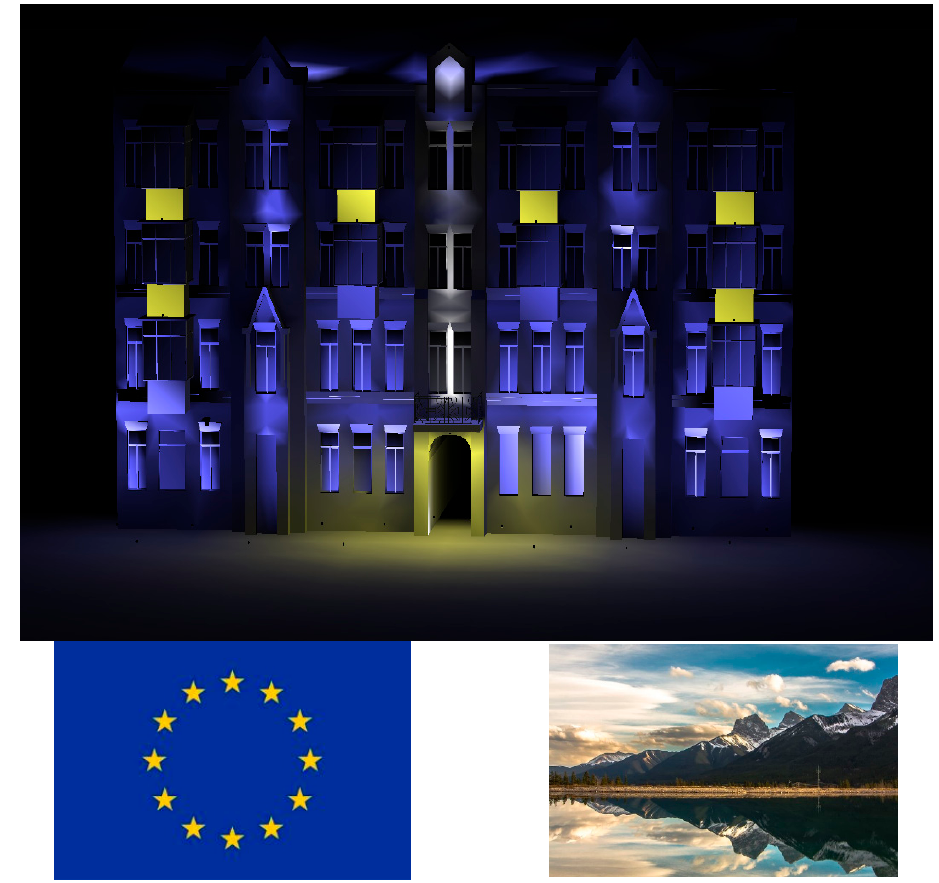
Figure 22. Seasonal façade lighting for EU solidarity ( top ) inspired by the flag and a technique ( bottom ) [82,83].